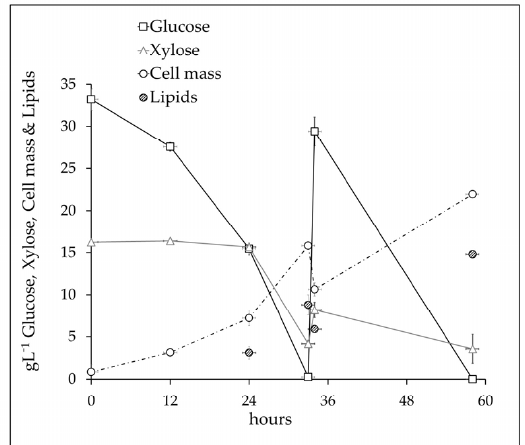
Figure 4. Scale-up of the process at 50 L bioreactor, in fed-batch mode, with L. tetrasporus DSM 70314 on wheat straw hydrolysate, soy flour as N sources, and C/N ratio of